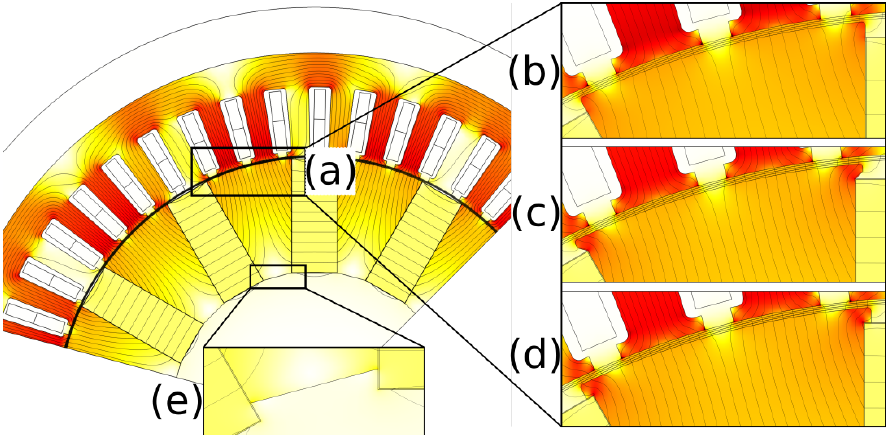
Figure 7. Different alterations of the rotating electrical machine. The different design alterations from ( a – e ) are denoted Default, Normal, Tangential, Closed and Shortened,